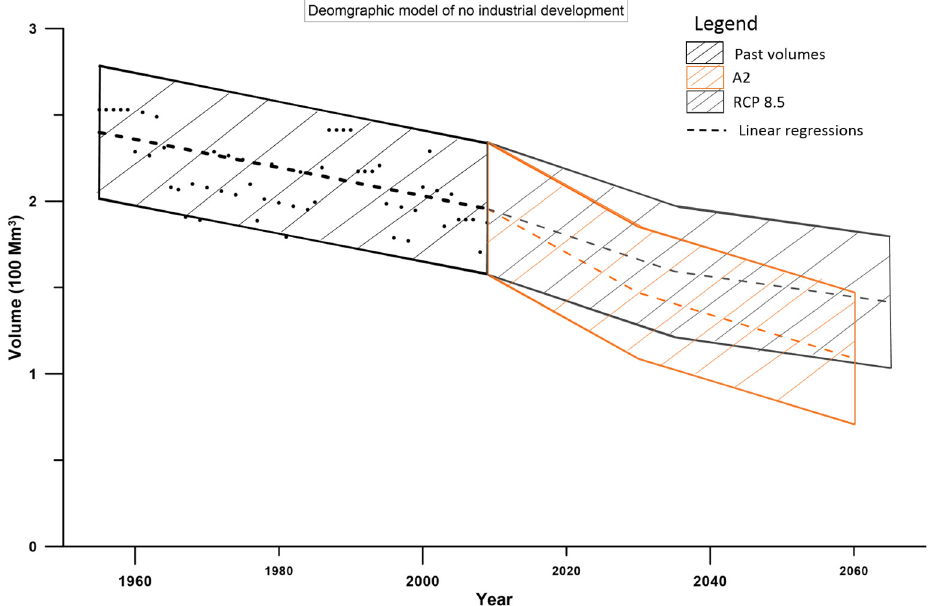
Figure 11. Graph, with the shaded areas representing the effective volume of Shela aquifer and projected volumes for A2 and RCP 8.5 climate change scenarios, as well as the uncertainties for the demographic model without the port (“no industrial